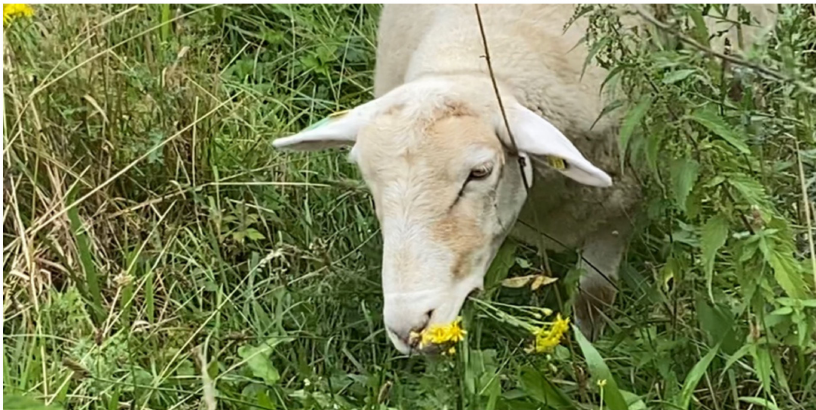
Figure 8. Sheep grazing ragwort flower in a rich pasture. (Date: 9 August